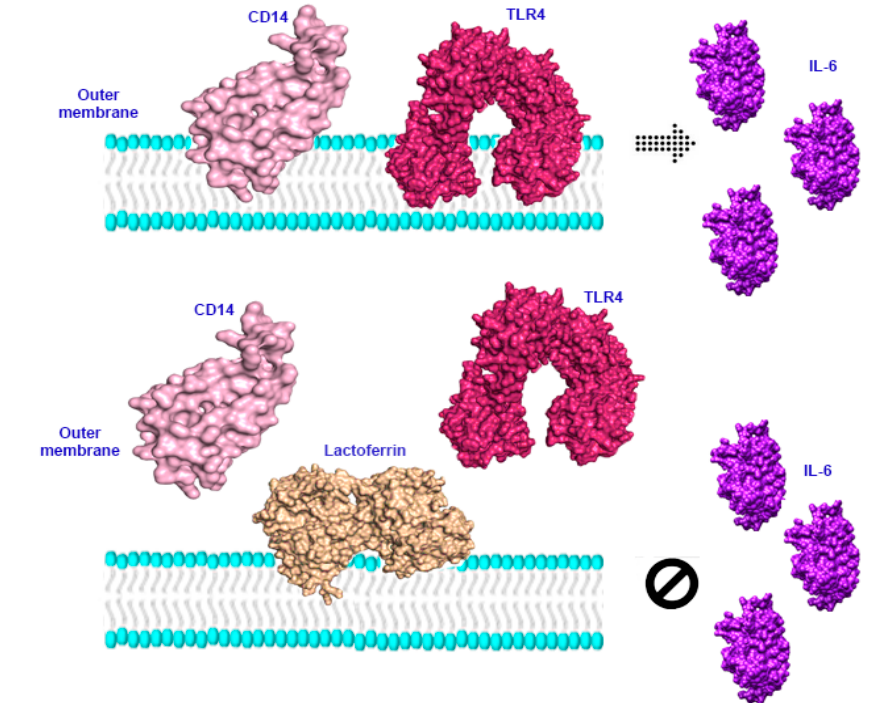
Figure 4. Schematic representation of the interaction of lactoferrin with LPS. ( A ) The interaction of LPS with CD14 can trigger an inflammatory response, with the release of some pro-inflammatory mediators such as IL-6 via TLR4. ( B ) In the presence of Lactoferrin, it can bind to LPS and block the interaction with CD14. Thus, the signaling of pro-inflammatory mediators through TLR4 can be diminished. The protein sequence was extracted from GenBank: CAG33297 (CD14), AF177765.1 (TLR4), and AAD13886.1